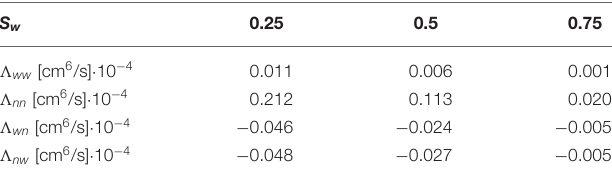
TABLE 4 | Integrated time correlation functions for case (B) and three different choices for the saturation.